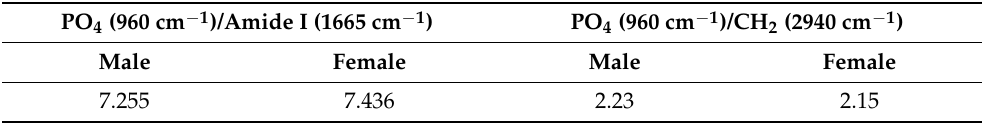
Table 3. Determination of the mineral-to-matrix ratio, as indicated by Raman intensity ratio of the corresponding bands, for spectra recorded on molar